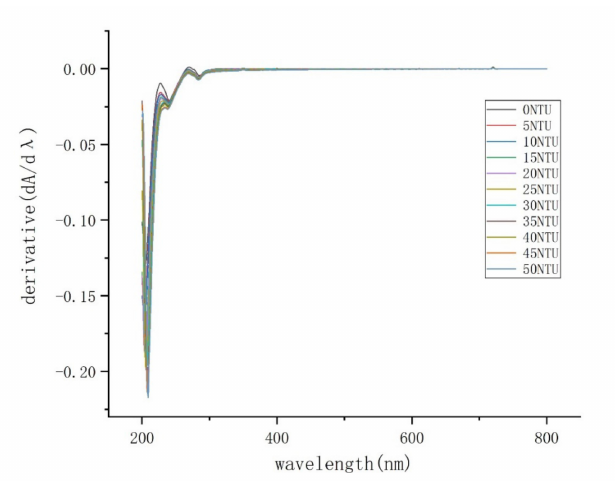
Figure 15. The first derivative of the UV–Vis absorption spectra of solutions with di ff erent turbidity.